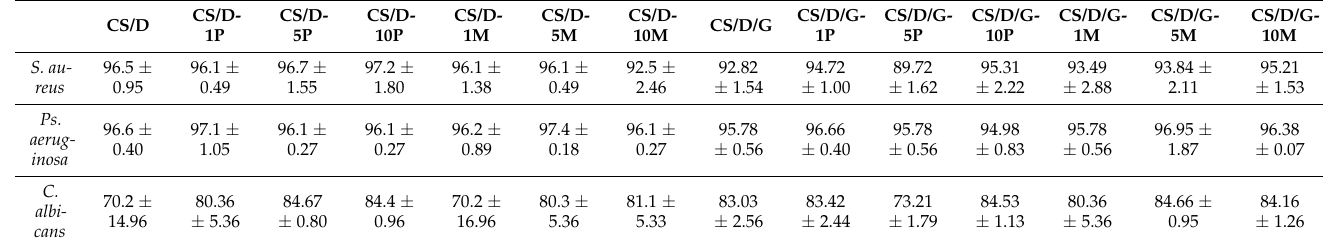
Figure 12. Logarithmic reduction (lg) converted as percentage reductions for hydrogel samples on three reference microorganisms; * p value < 0.02 ( n = 3). Table 4. Antimicrobial activity of hydrogel samples expressed as percentual reduction values.